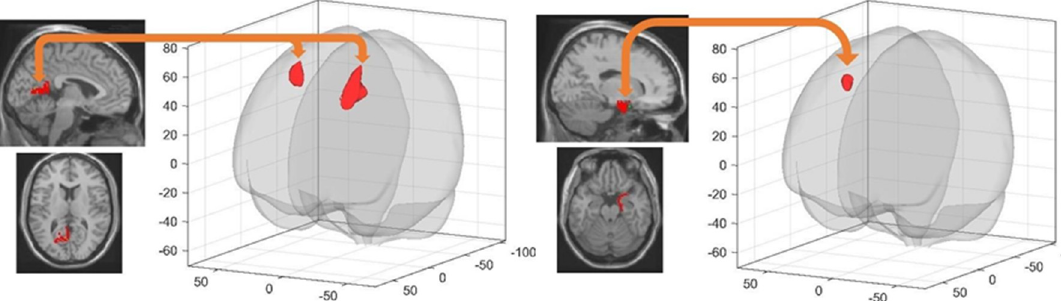
Figure 3. Higher seed-based FC in SD than RS participants between (left panel) left retrosplenial cortex (seed) and two frontal clusters (target left superior frontal gyrus and right middle frontal gyrus; cluster p FWE > 0.00005) and (right panel) right entorhinal cortex (seed) and a right frontal gyrus cluster (target; cluster p FWE < 0.002). Target clusters are visualised using the CONN toolbox glass display [46]. Seed areas are displayed on the mean MNI template (SPM12 software, Wellcome Department of Cognitive Neurology, London). Table 2. Post training Sleep-Dependent Relearning-Related Changes in resting state seed-based FC on Day 4 (rsfMRI 4 > rsfMRI 3, SD > RS).